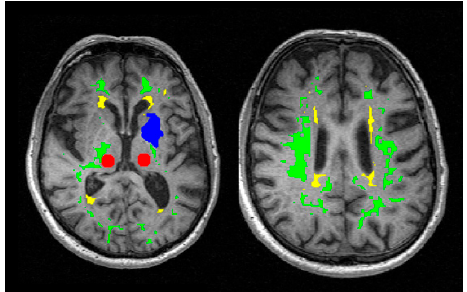
Figure 6. Regions of interest overlaid on the first image of the DESPOT1-HIFI series prior to USPIO infusion. Regions and segmentation masks shown are the manually drawn thalamus ROI (red), normal-appearing white matter (green), white matter hyperintensities (yellow) and the manually drawn stroke lesion ROI (blue).